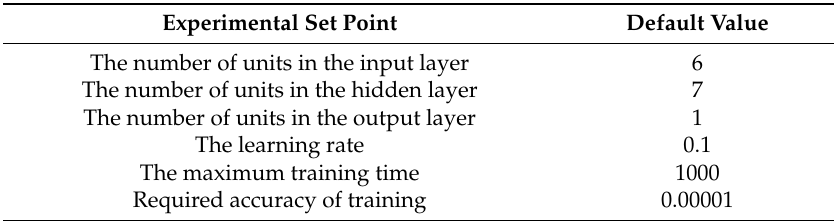
Table 2. The experimental set points of